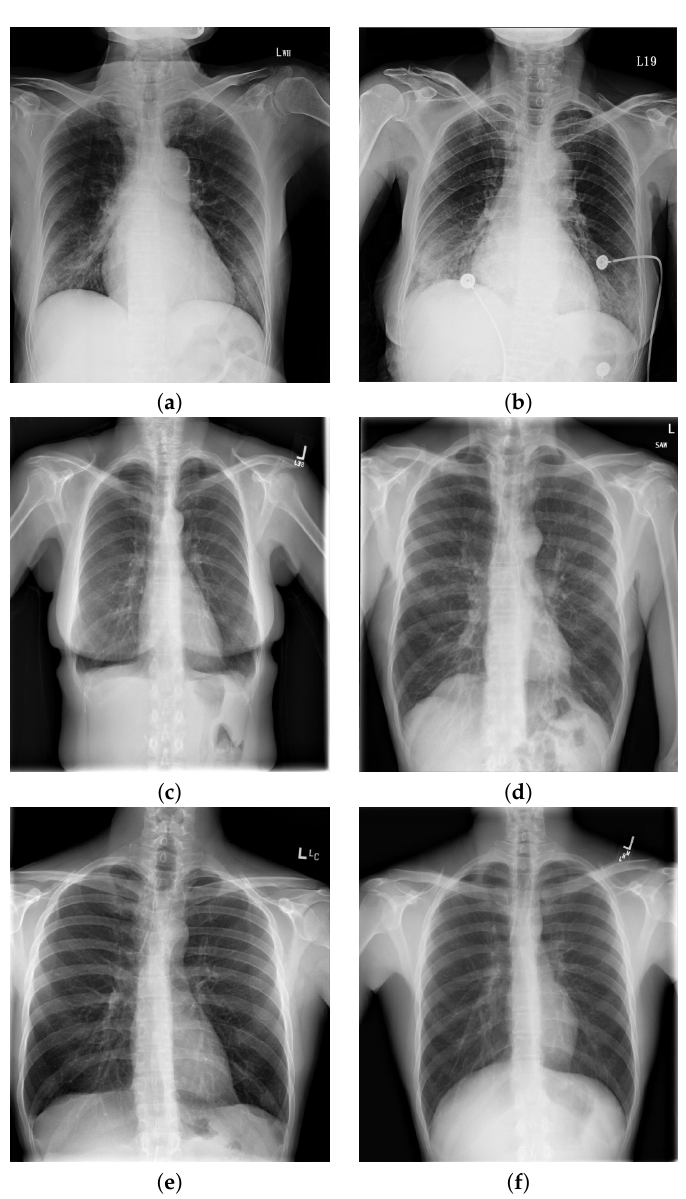
Figure 12. Example of X-rays: ( a , b ) coronavirus (COVID-19); ( c , d ) other diseases; and ( e , f ) healthy. Source: prepared by the